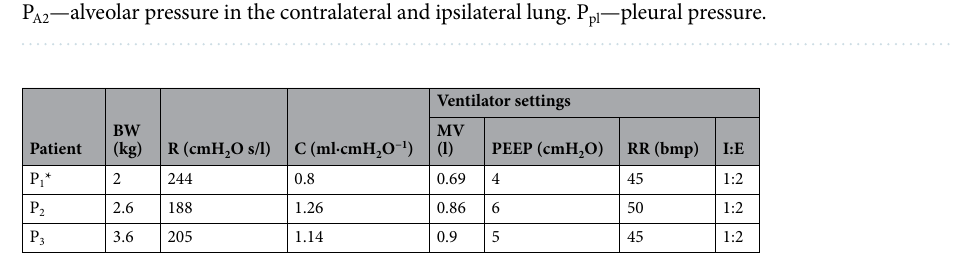
Table 2. Clinical data used in the simulations. *P 1 , P 2 , P 3 —enrolled patients, BW body weight, R total respiratory system resistance, C total compliance of respiratory system, MV minute ventilation, PEEP